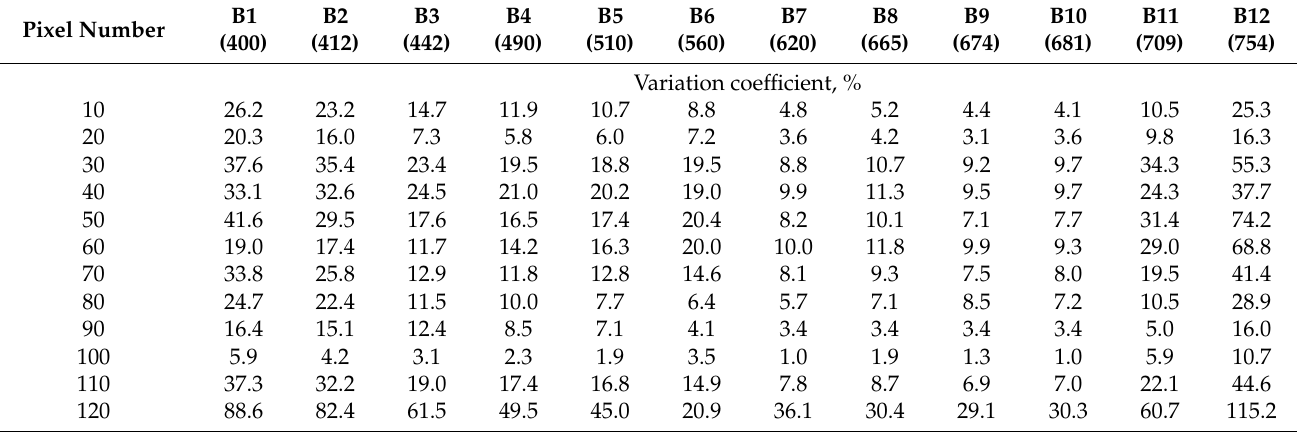
Table 2. Variation coefficient for remote sensing reflectance in Sentinel-3 bands for some matchup points along the motorboat route.